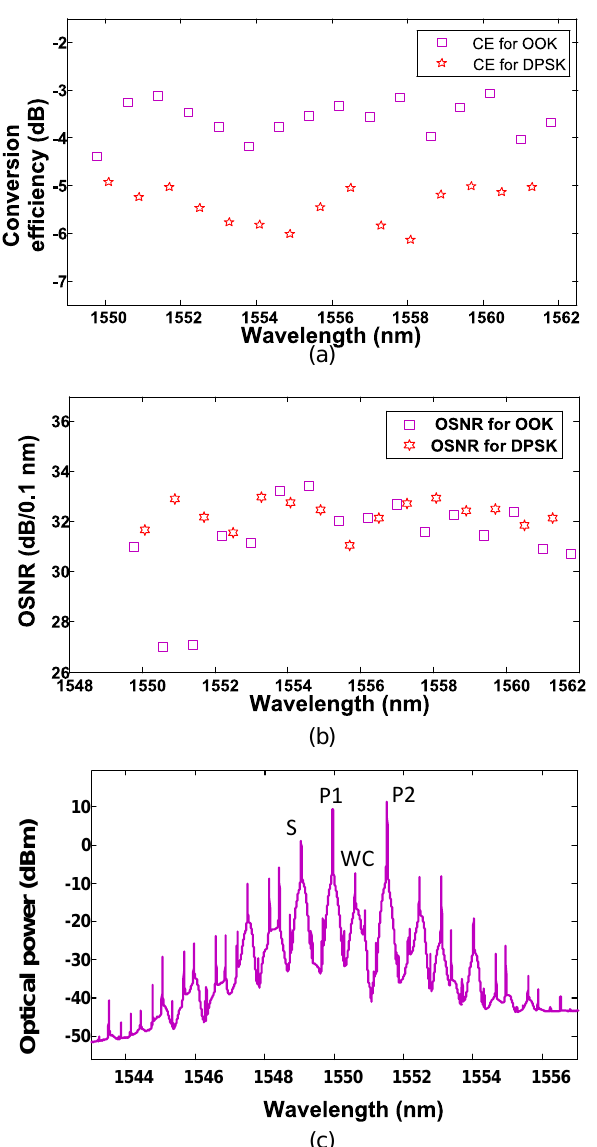
( a ) Conversion efficiency (dB), input at λ signal-to-noise ratio (OSNR) (dB/0.1 nm) for OOK and DPSK, and ( c ) spectrum for OOK conversion from λ to λ 1 3